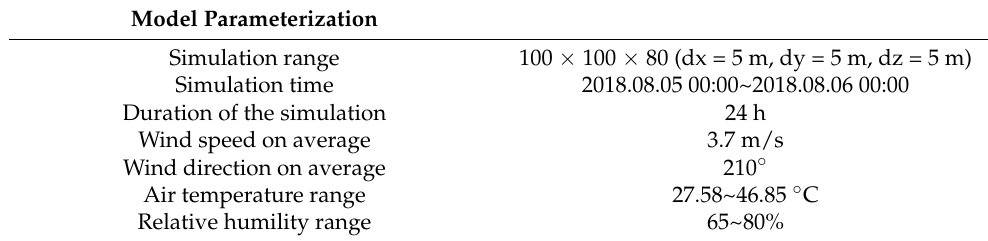
Table 2. ENVI-met simulation initial model input